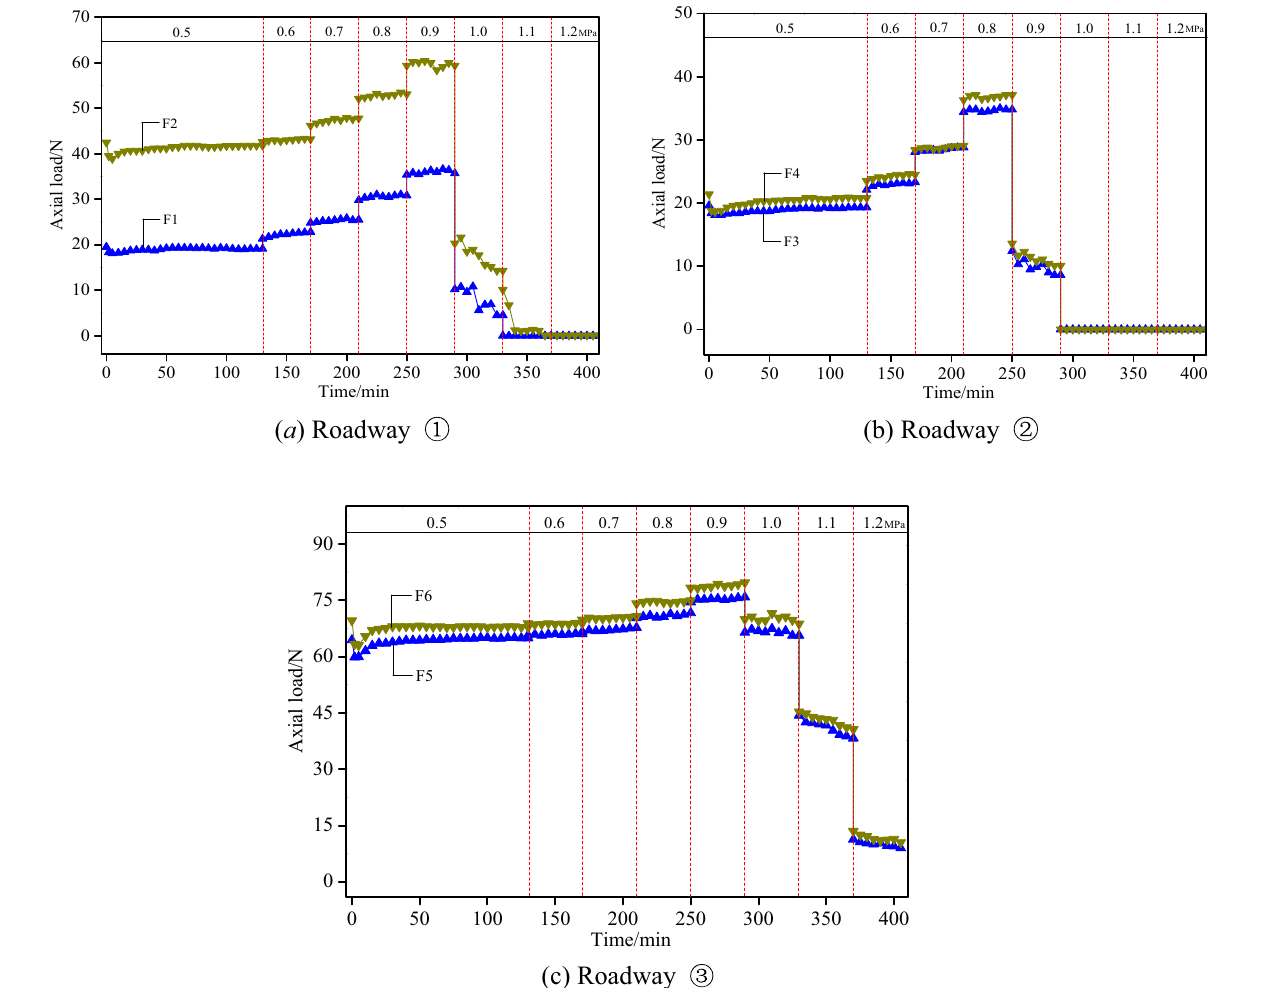
Figure 15. Variation curves of axial load of experimental